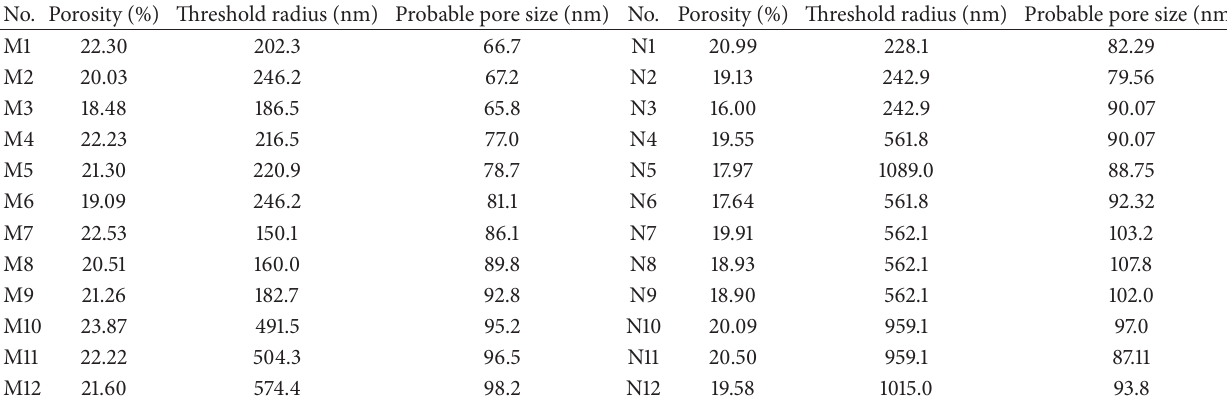
Table 3: Parameters of pore structure of cement